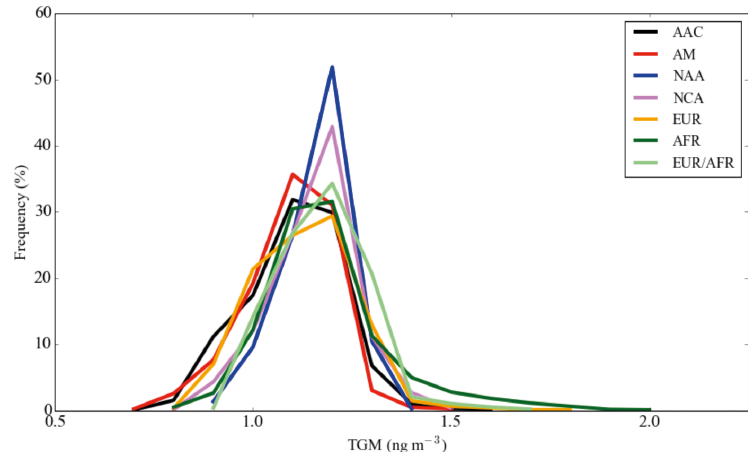
Figure 6. Histograms of observed TGM classified by air mass for the full 2011–2015